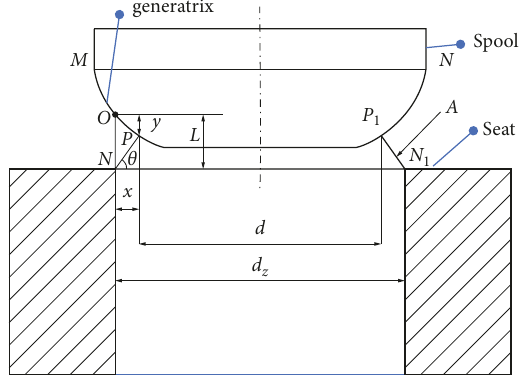
Figure 1: Seat valve